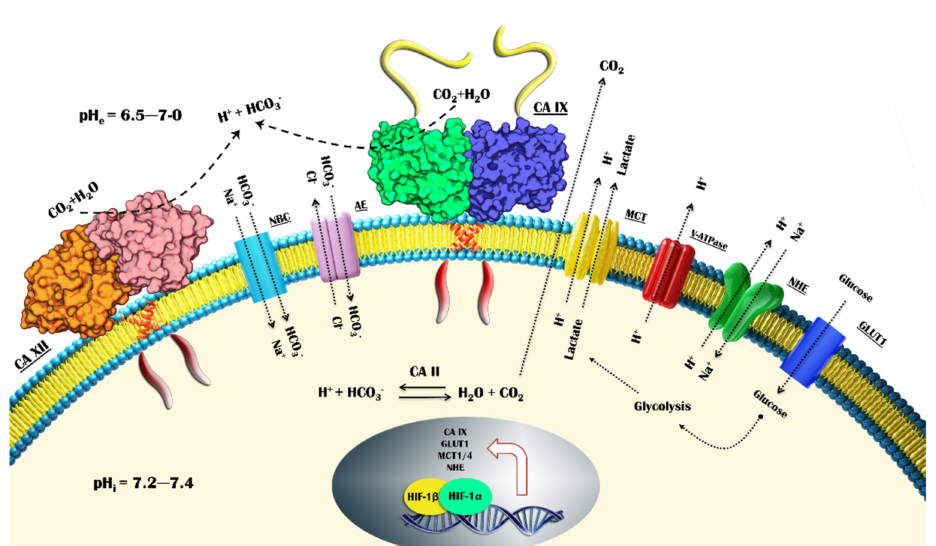
Figure 1. pH modulation system in hypoxic tumor cells. HIF-1 upregulates the expression of glucose transporters (GLUT1), glycolytic enzymes, and proteins involved in pH regulation: monocarboxylate transporter (MCT), V-type H+ATP (V-ATPase), Na+/H+ exchanger (NHE), bicarbonate co-transport (NBC), anion exchanger (AE), and carbonic anhydrase IX (CA IX) and XII (CA